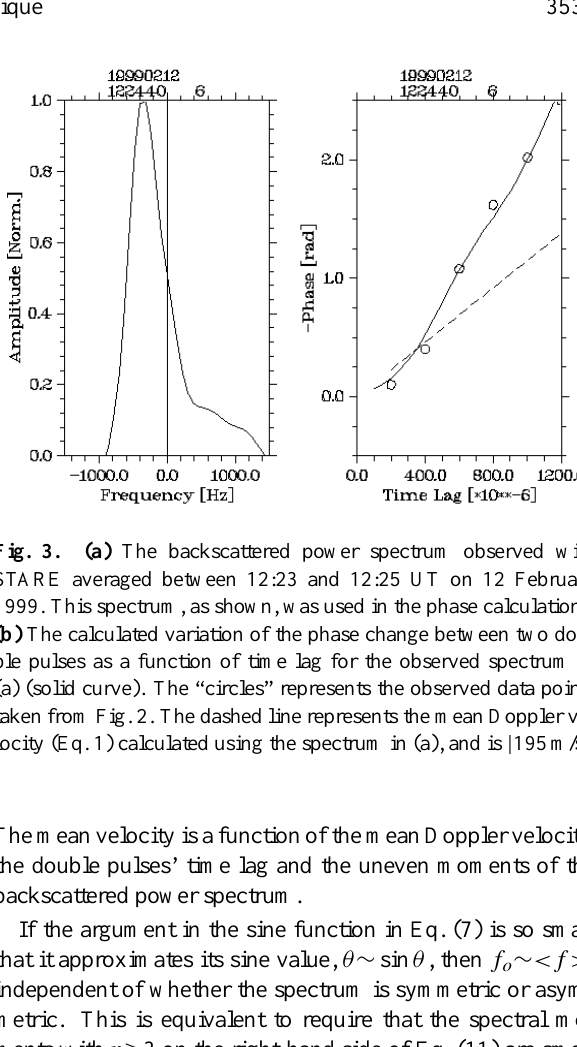
Figure 2: Phase, φ , versus time lag (= Lag Number * 200 us) for STARE multi pulse experiment (after Figure 5b in Uspensky et al., 2004). The observed variation of phase with time lag has features similar to the general predicted behavior (Figure 1b). For small lags the phase shift is reduced in magnitude compared to the shift associated with larger lags. Figure 2 shows that φ and T are not proportional, but rather that the ratio between the phase and lag time tends to increase with increasing lag time. Thus, the mean frequency is observed to be an increasing function of time lag. From Figure 2 we find a variation of the Doppler velocity from 180 m/s at 200 µ s to 345 m/s at 1200 µ s, and 380 m/s for a linear fit to all the observations. The observed variation of ‘ φ vs T’ can be accounted for by the observed asymmetric backscatter power spectrum. The average backscattered power spectrum observed with STARE over a 2 minutes time interval centered on 1224 UT is shown in Figure 3a. It has an asymmetric main peak, as the simple spectrum in Figure 1a, and in addition a tail extending towards negative frequencies. Using this observed spectrum and Equation 7, the phase variation with time lag was determined, Figure 3b.